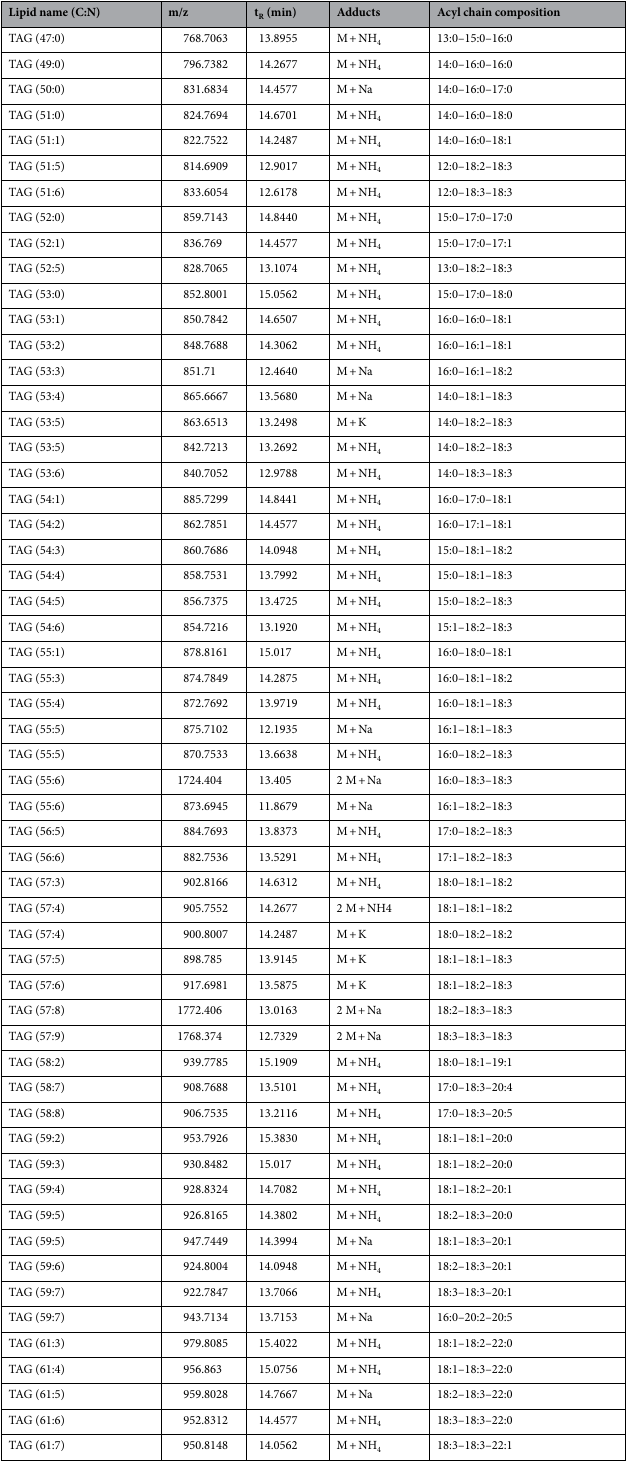
Table 1. Molecular species of triacylglycerols (TAGs) identified in the Paeonia ostii seed kernel. Lipid compounds were selected using a scoring system. First, lipids were scored, based on accurate mass numbers, secondary fragments, and isotope distributions. Each of these criteria were assigned a maximum potential score of 20 points to yield a maximum potential total score of 60. Second, because the mass spectra of the secondary fragments are relatively important, we also calculated a fragmentation score (maximum 100 points). We then identified the TAG molecular species with fragmentation scores > 60 and scores > 45. C:N represents the total number of carbons (C) and the number of double bonds (N). t R indicates retention time. The fatty acyl chains of the listed TAG molecular species were assigned based on the major FA-fragment ions observed in the MS/MS spectra of each TAG. Details of the listed TAG molecular species are given in Supplementary Table